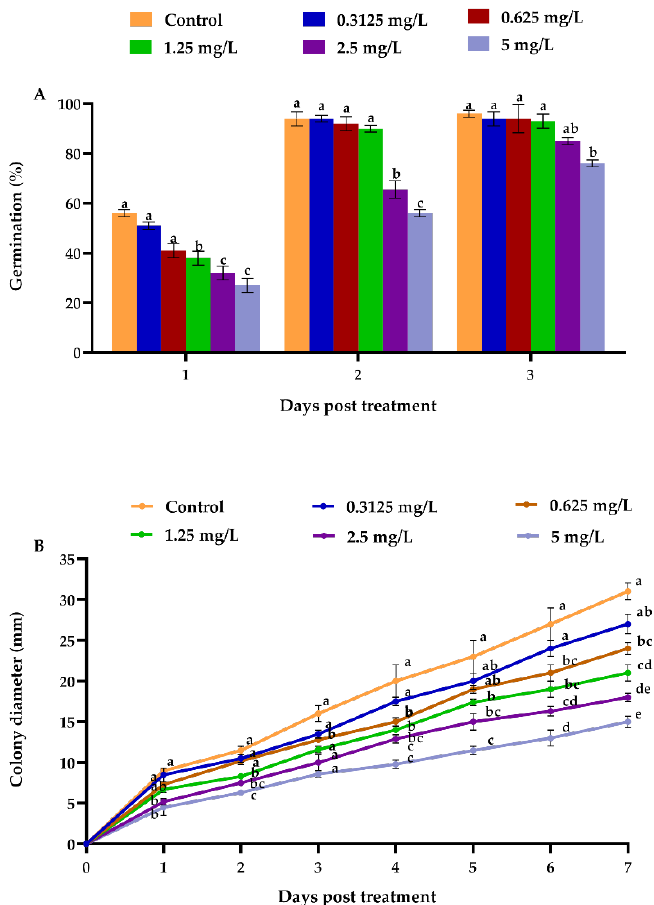
Figure 1. Emamectin benzoate effect on the biological features of B. bassiana . ( A ) Germination rate (%); ( B ) colony diameter (mm). Error bars indicate standard error of means based on three replicates. Bars with different letters indicate significant differences between treatments at various periods of time (Tukey’s test at 5% level of significance).